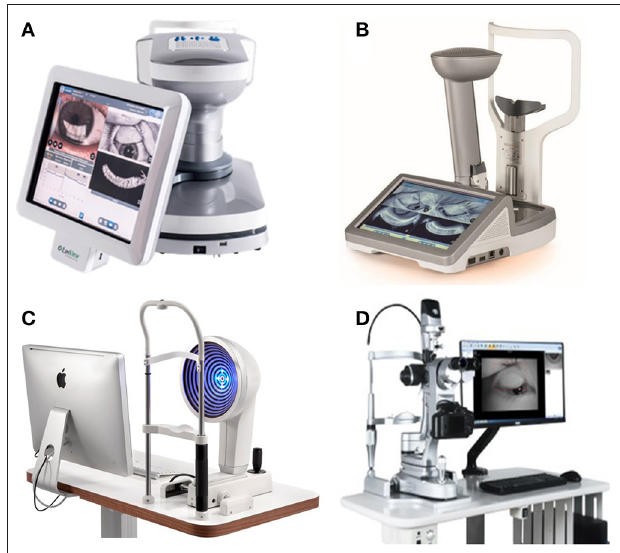
FIGURE 7 | Dry eye analyzers. (A) LipiView II ocular surface interferometer. (B) LipiScan dynamic meibomian imager. (C) OCULUS Keratograph 5M. (D) Kanghua dry eye